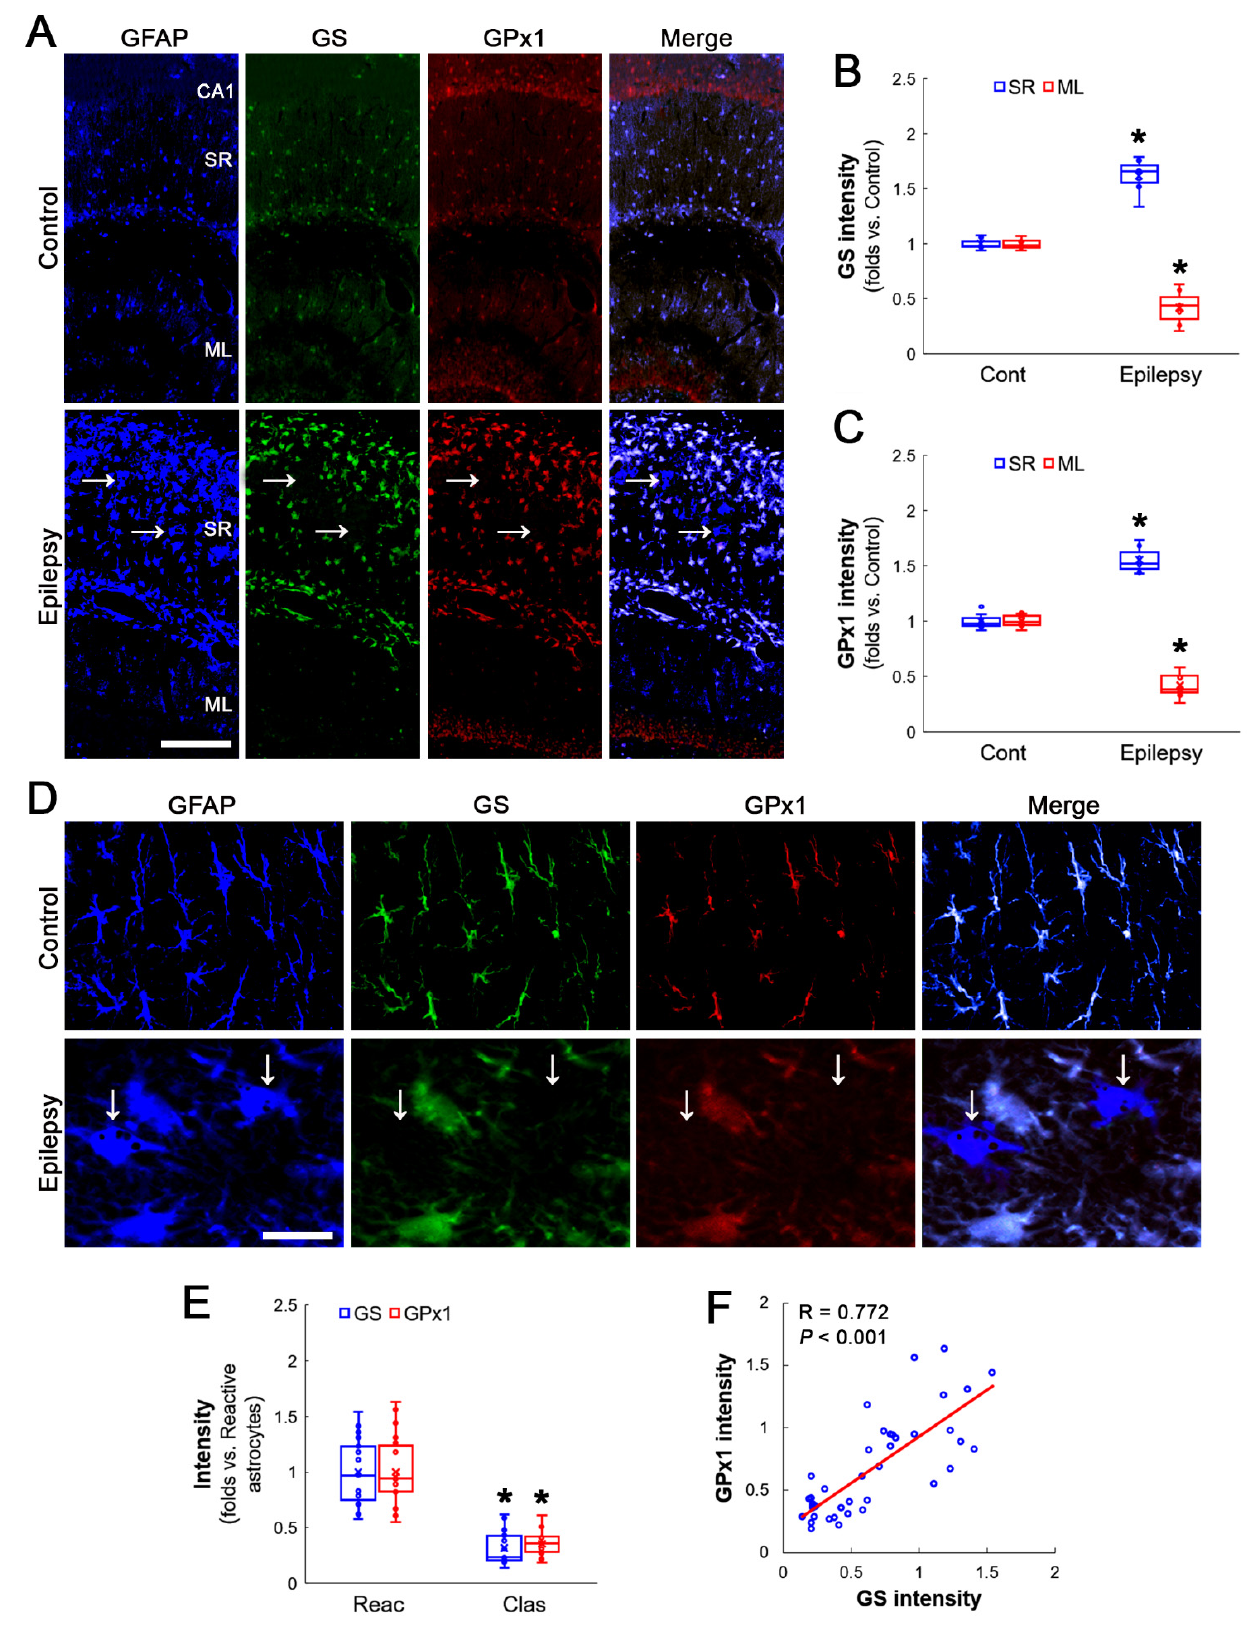
Figure 1. Alteration in GS and GPx1 expressions in the rat hippocampus of chronic epilepsy rats. GS expression is mainly observed in astrocytes (GFAP, an astroglial marker) under physiological